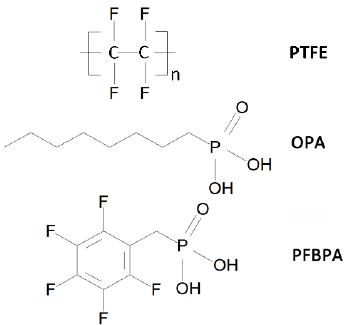
Figure 1. Molecular structures of polytetrafluoroethylene (PTFE), octyl phosphonic acid (OPA), and pentafluorobenzyl phosphonic acid